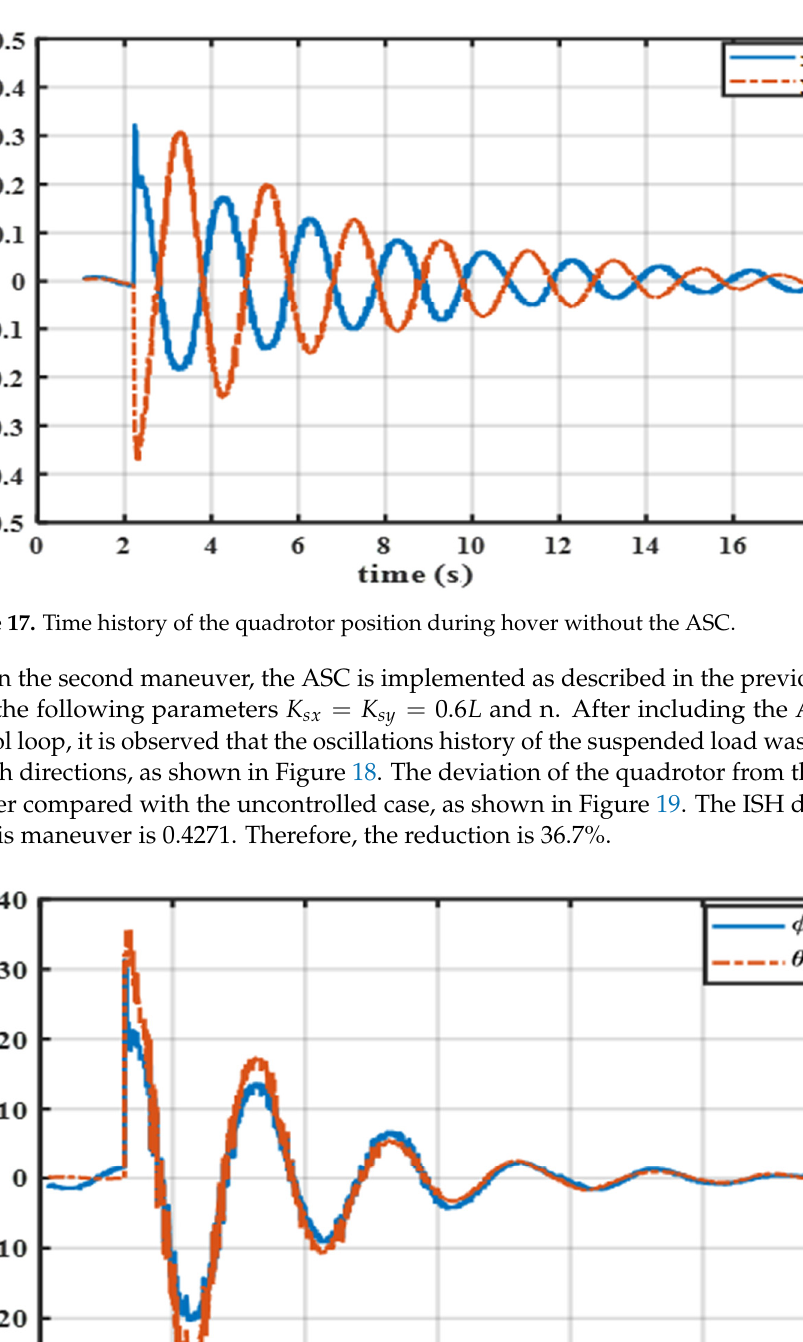
Figure 16. Time history of the load swing angle during hover without the ASC.